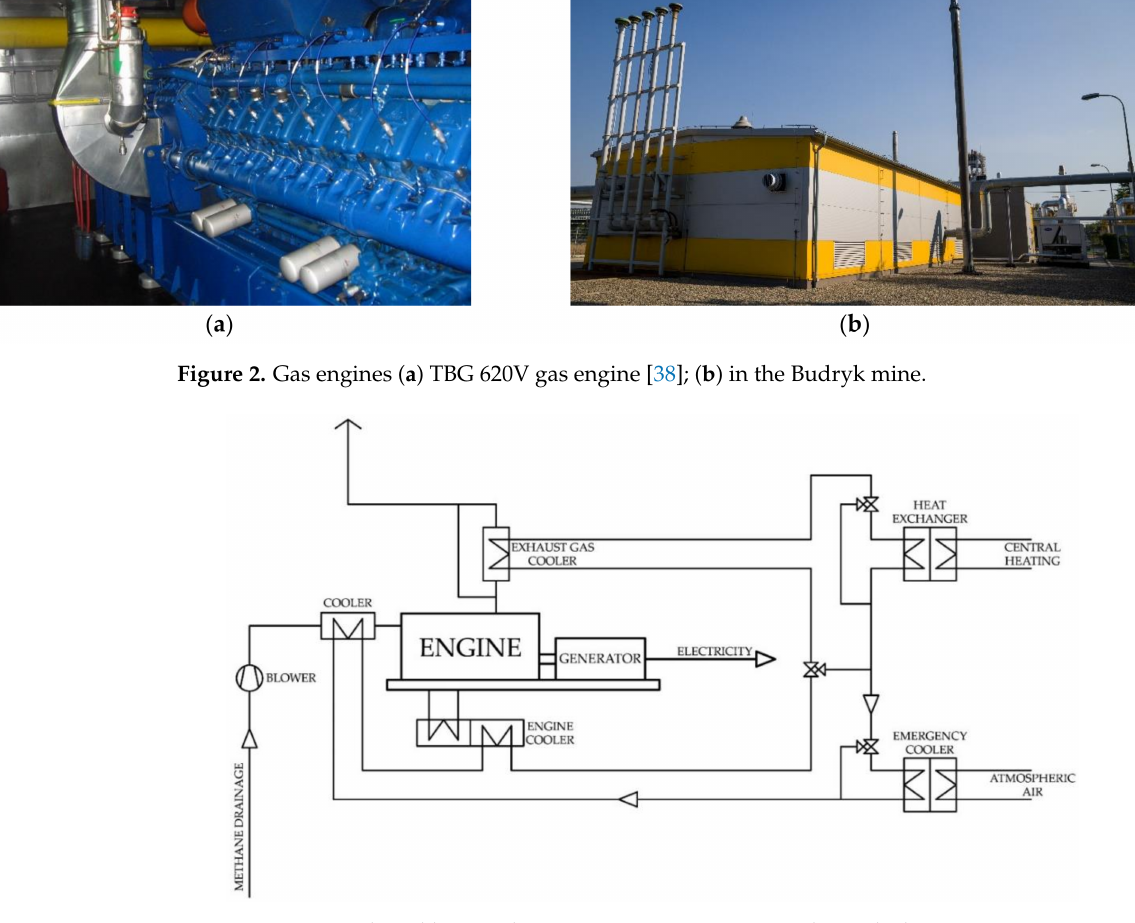
Figure 3. Combined heat and power generation system at the Budryk mine.